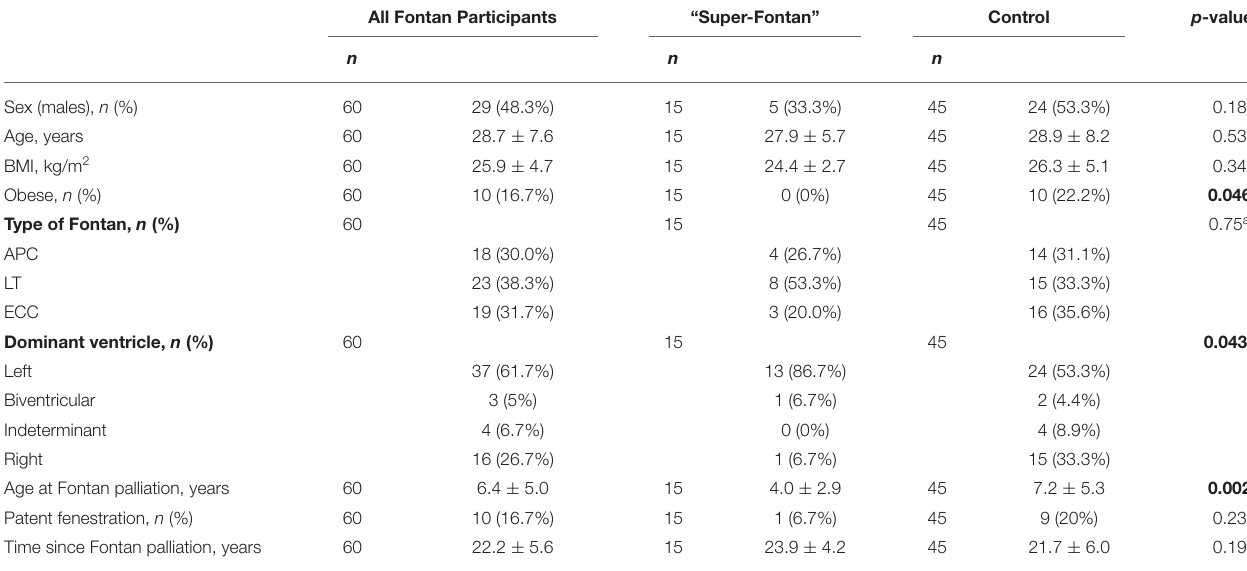
Figure 1 . Childhood physical activity was higher in the “Super- Fontan” group compared to the control group (3.9 ± 3.3 h/wk vs. 2.0 ± 3.4 h/wk, p = 0.04). The average h/wk of sports and physical